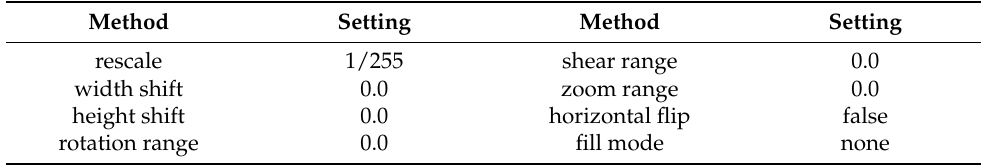
Table 2. Parameter settings of data augmentation.